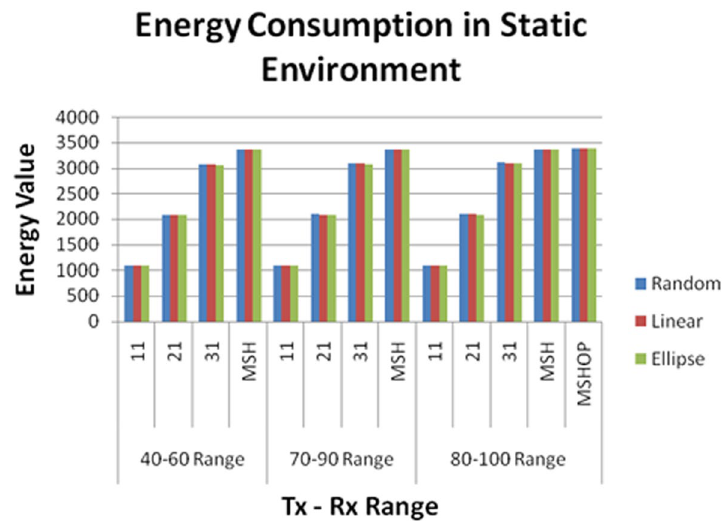
Fig. 31 Total energy in static environment